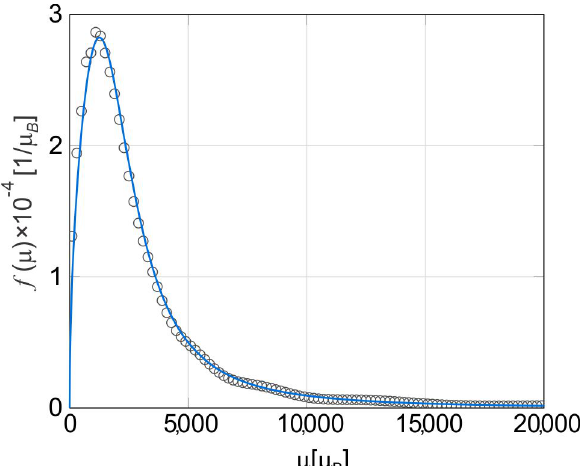
Figure 4. Representation of the probability density function f ( µ ) (continuous solid line), defined in Equation (15), and its approximation, obtained from taking a numerical derivative of F A , n ( µ ) with A = 10 5 µ B and n =